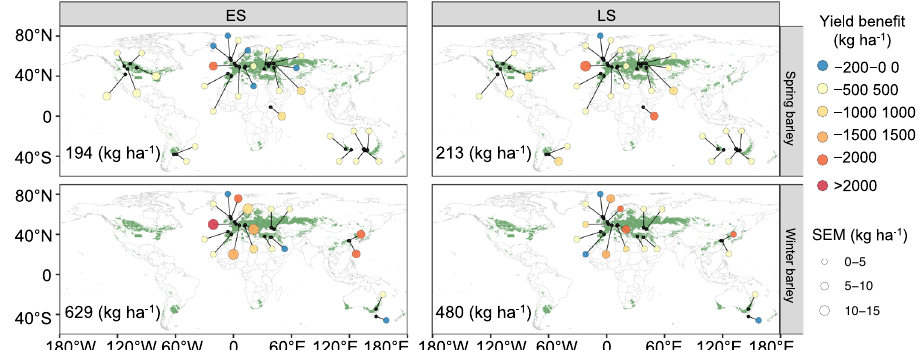
Fig. 5 | Mean and standard error of the mean (SEM) for grain yield bene fi t associated with waterlogging tolerant genotypes relative to waterlogging susceptible genotypes for 2040 (2030 – 2059). Values were computed across yearsand27GCMsinwhichbarleygrowingseasonrainfallwashigherthanthe90th